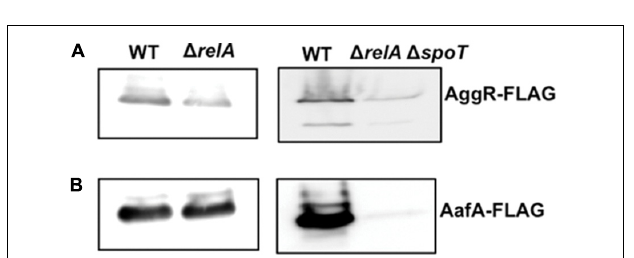
FIGURE 3 | Effect of the double relA spoT mutation on transcription of aggR , and AggR-activated genes in strain 042. Fold change values (qRT-PCR values) of aggR , and AggR-activated genes aafA , aafD , aatP, and aap in strain 042 (cid:49) relA (cid:49) spoT . Expression of the corresponding genes in the 042 WT strain was considered as 1.0. The data shown are the means and standard deviations of three independent experiments are shown.